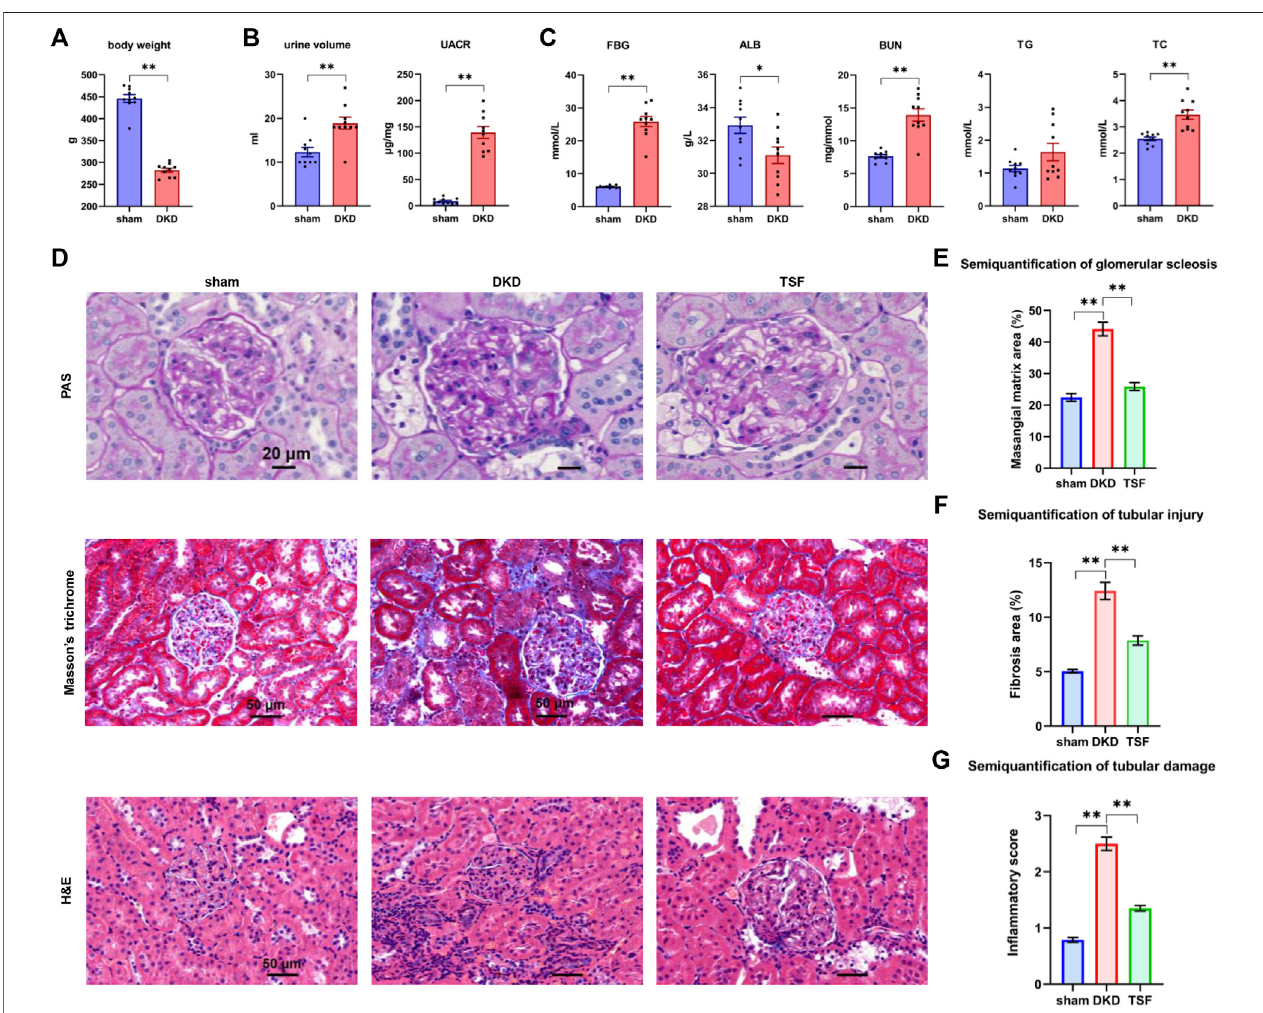
FIGURE 1 | Signi fi cant shift in physiologic and biochemical parameters and kidney pathology in DKD rats, and the effects of TSF treatment on renal damage. (A) Bodyweightof rats in the sham and DKD groups. * p < 0.05, ** p < 0.01, versus sham rats. (B) Urinary parameters of sham and DKD rats. (C) Biochemical parameters in rat serum in the sham and DKD groups. (D) H&E, Masson trichrome, and PAS staining. (E – G) Semi-quanti fi cation of mesangial matrix, fi brosis area, and in fl ammatory scores based on PAS, Masson trichrome, and H&E staining, respectively. * p < 0.05, ** p < 0.01.